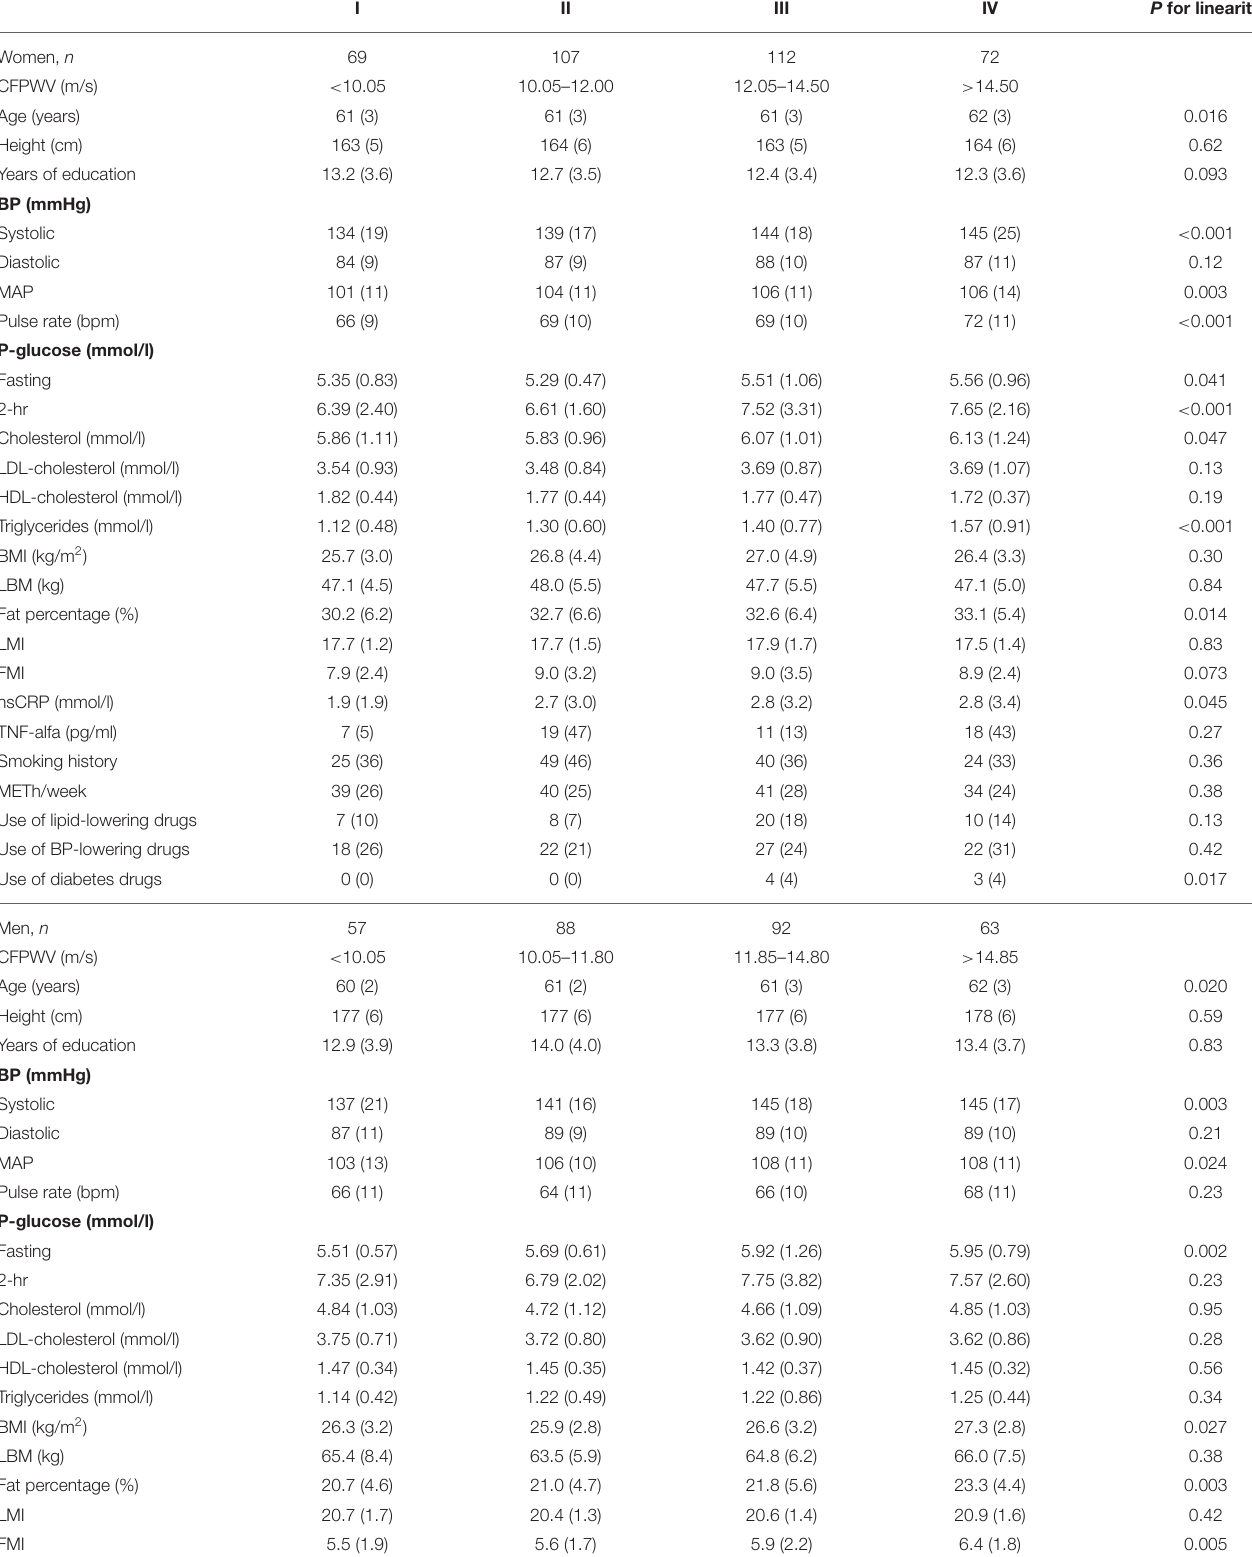
TABLE 1 | Baseline clinical characteristics of the study participants divided into four groups of carotid-femoral pulse wave velocity (CFPWV) * in the 15-year follow-up. I II III IV P for linearity Women,